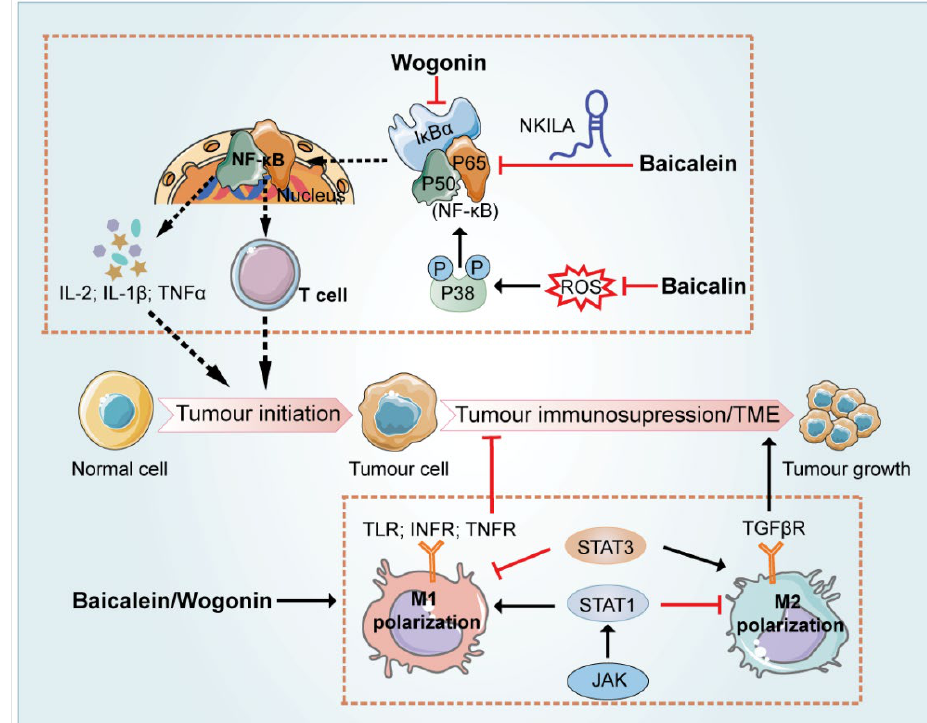
Figure 3. Molecular signaling networks underlying the anti-inflammatory and immunoregulative effects of baicalein, wogonin, along with their glycosides (baicalin and wogonoside). Baicalein promotes the physical interaction between NF- κB interacting LncRNA and NF - κB/IκB, inhibits IκBα phosphorylation and NF- κB nuclear translocation, therefore decreases NF - κB activity and exerts anti-inflammatory effect against tumors. Baicalin and wogonin improve immune and inflammation abnormality through the blockade of pro-inflammatory signaling pathways (such as TLR/NF- κB and JAK/STAT3), induction of cancer cell apoptosis, as well as macrophage reprogramming from an M2 to an M1 phenotype.